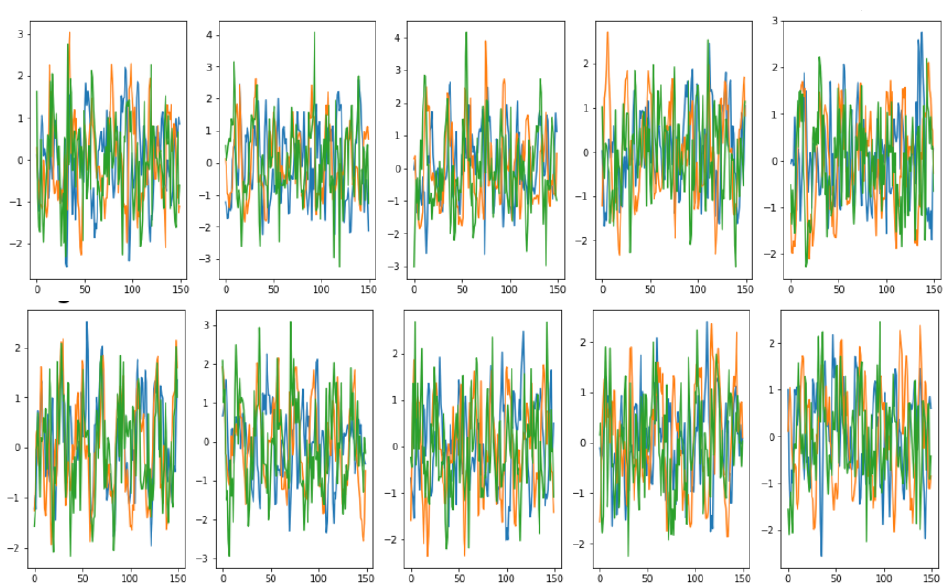
Figure 12. Generated synthetic data for running